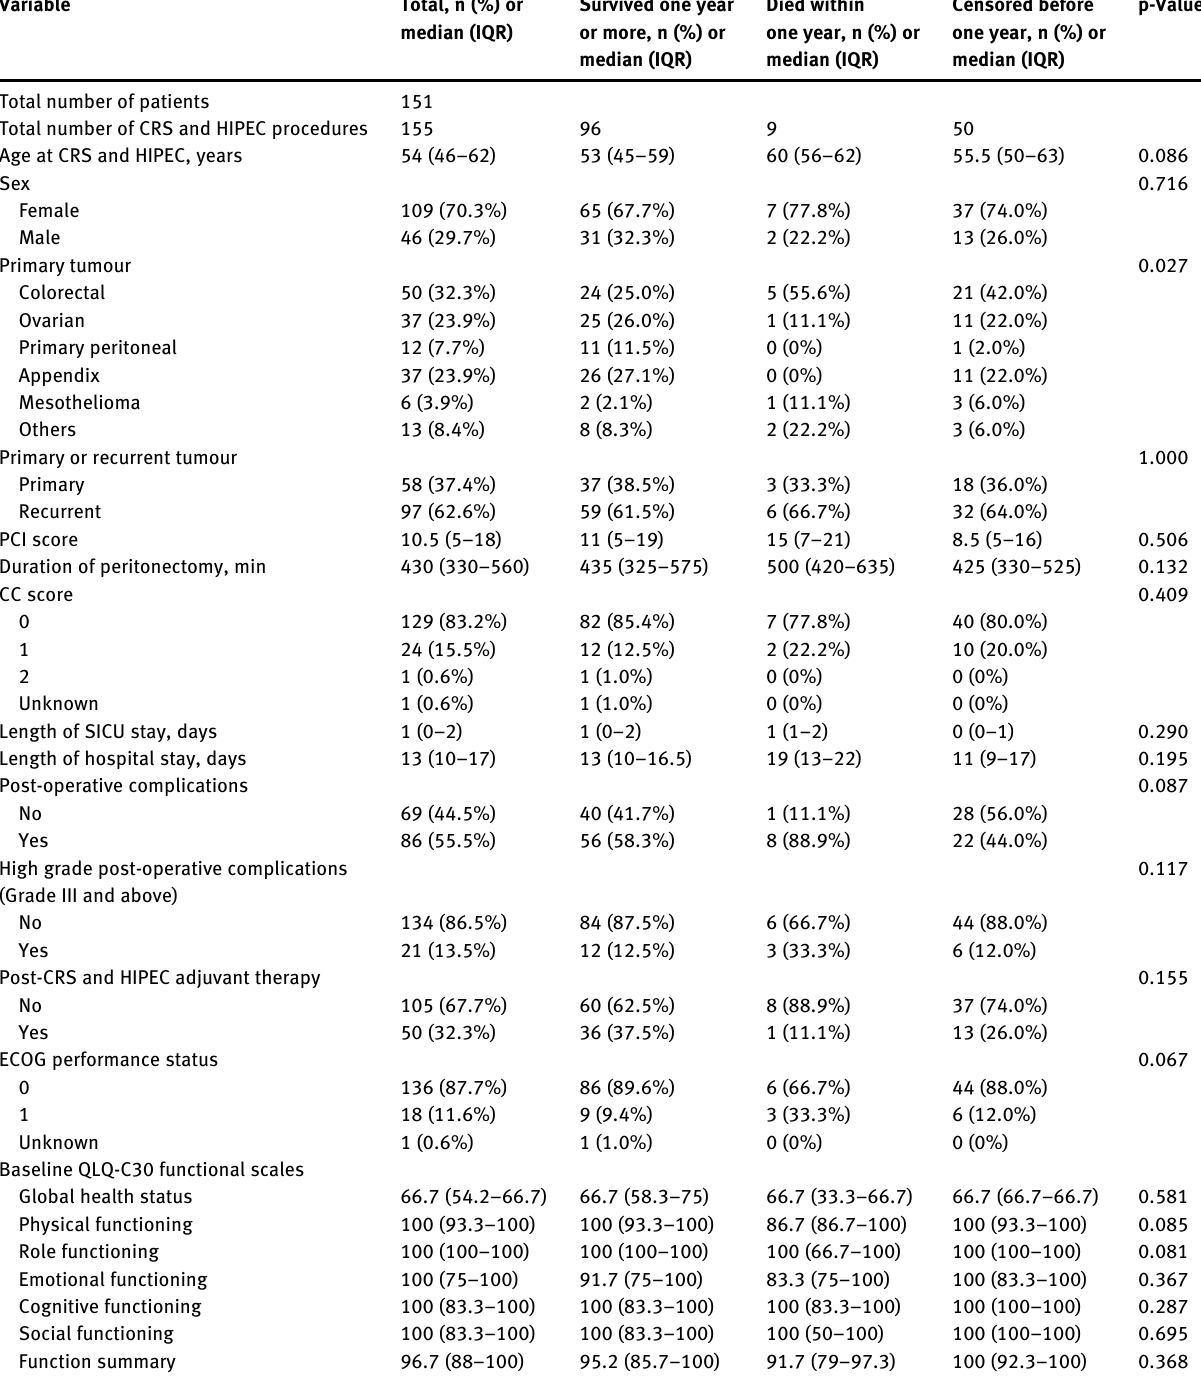
Table  : Comparison of patient demographics, surgical characteristics and baseline,  ,  and  months QoL scores between procedures wherepatientsdiedwithinoneyearandthosewherepatientssurvivedmorethanoneyear.Atbaseline,patientswhodiedwithinoneyearhad higher appetite loss and diarrhoea scores compared to patients who were still alive at one year. Primary tumour types distribution was signi fi cantly different between two groups. There was a stark contrast between two groups in global health status, physical functioning, role functioning, emotional functioning, fatigue, pain, appetite loss, symptom summary, nausea and vomiting at three months; global health status, physical functioning, role functioning, social functioning, function summary, fatigue, pain, dyspnoea, appetite loss, symptom sum- mary, nausea and vomiting at 